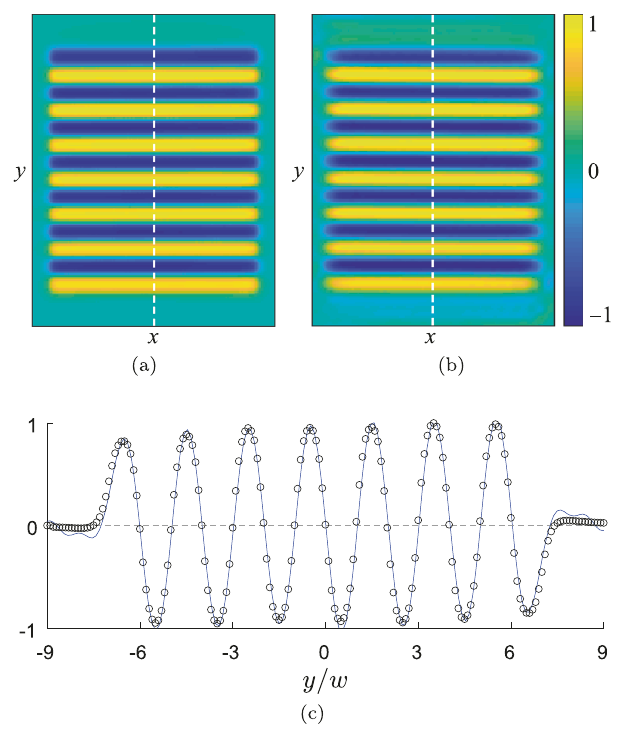
Fig. 4 Forcing fi eld. The x -component of the depth-averaged Lorentz force J × B computed using experimental measurement of the magnetic fi eld ( a ) is virtually indistinguishable from the forcing fi eld f reconstructed using Eq. (8) for Re = 22.17 ( b ). In c , the reconstructed (blue line) and measured (black circles) forcing pro fi les, both normalized by their maximum magnitude, are compared along the line x = 0 (dashed lines in ( a ) and ( b )). This normalization which is used in all three panels, also removes the dependence on an arbitrary choice of ρ in Eq.